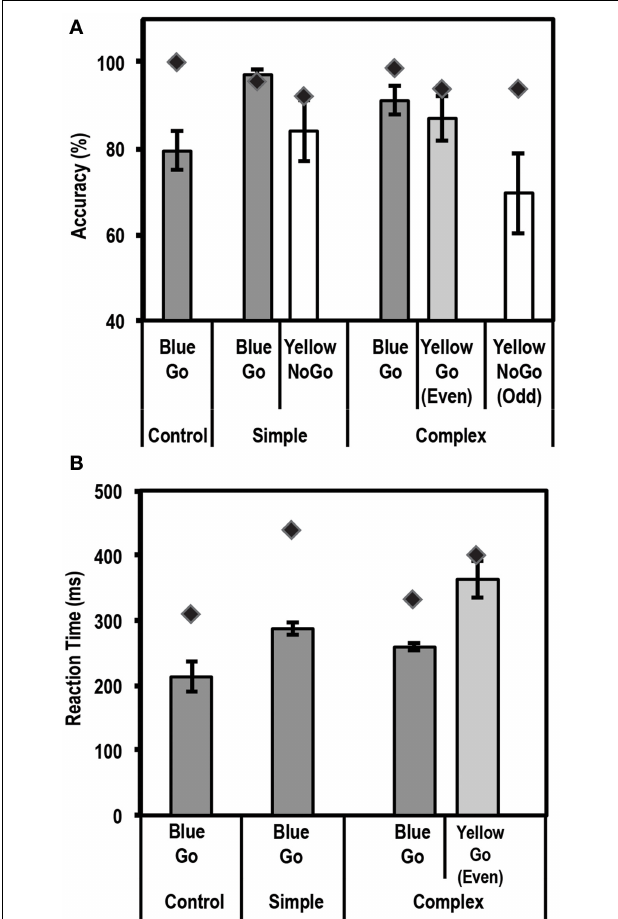
FIGURE 5 | Average accuracy (A) and reaction time (RT) data (B) for controls ( N = 5) and the patient for the Go/No-Go Task. Dark gray bars represent performance on Go trials. Unshaded bars represent performance on No-Go trials when subjects were expected to withhold their response (i.e., yellow box in the simple task, and yellow box preceded by an odd number of blue boxes in the complex task). Light gray bars represent performance on complex No-Go trials when subjects were expected to press a button (yellow box preceded by even number of blue boxes). Error bars represent standard error of the mean for the control group. Diamond markers indicate performance of the patient. The patient performed as accurately as controls on all trial types but was slower to respond on Simple Go and Complex Go trials.